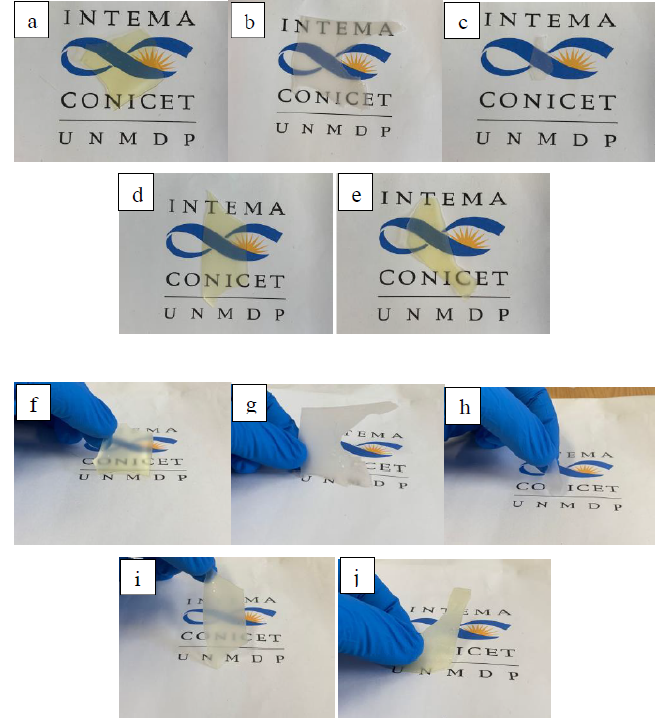
Figure 1. WBPU films: ( a , f ) CO-TA. ( b , g ) PCL-DMPA. ( c , h ) PCL-TA. ( d , i ) CO-TA(80)/PCL-TA(20). ( e , j ) CO-TA(80)/PCL-DMPA(20). The color differences between the samples were also quantified using